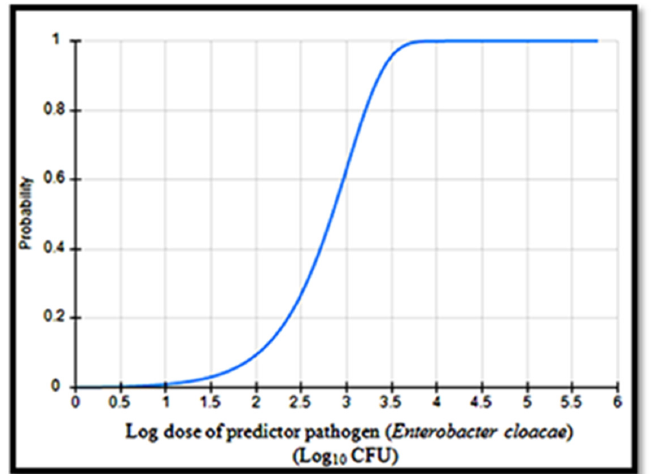
Figure 3. Dose-response curve of the Enterobacter cloacae pathogen. The dose-response curve was implemented with the FDA-iRisk version 4.0 software